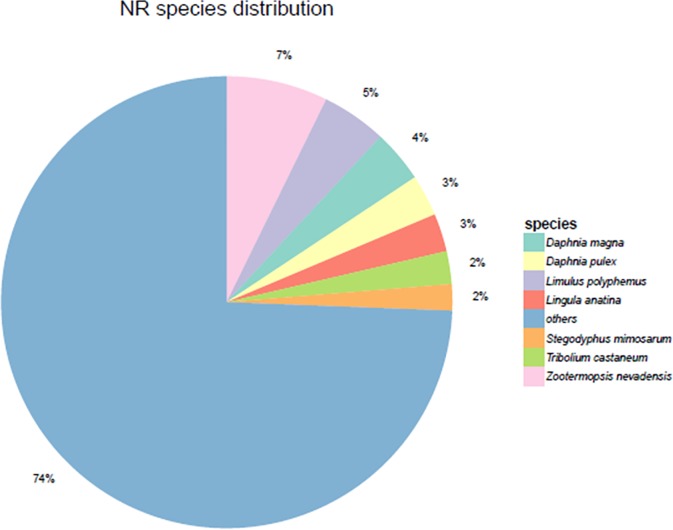
Species distribution of BLASTx hits.